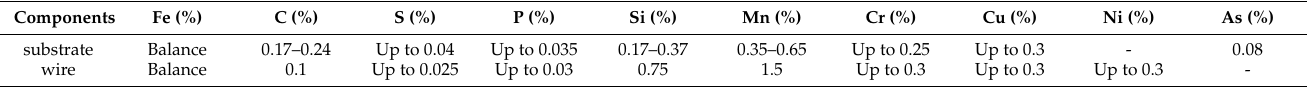
Figure 2. Process oscillogram, 1—short circuit, 2—peak current, 3—arc burning.